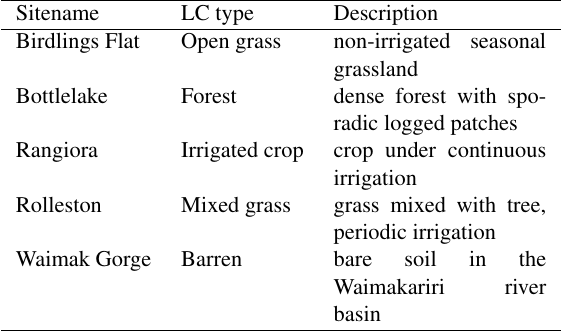
Table 1: In-situ measurement sites and their LC types each of the sites. These codes are meant to read data from the entire list of LST HDF files for the analysis period based on the coordinates of each test-site and arrange data-fields alongside the related fields (i.e., LST for day and night fields, quality control field, view-angle and overpass-time fields). Afterwards, dates based on HDF filenames and overpass-time field from the LST SDSs were used in the code to produce sequentially ordered val- ues as time-series from each test-site. It should be mentioned that these time-series are restricted to the available MODIS ob- servations (four times daily in ideal conditions), which is further restricted to those times when cloudless data were available. An- other code was written to match dates and times from LST time- series with the in-situ SM data; this code appends matching data, alongside with the in-situ SM date-time, as extra columns in the time-series of each test-site.